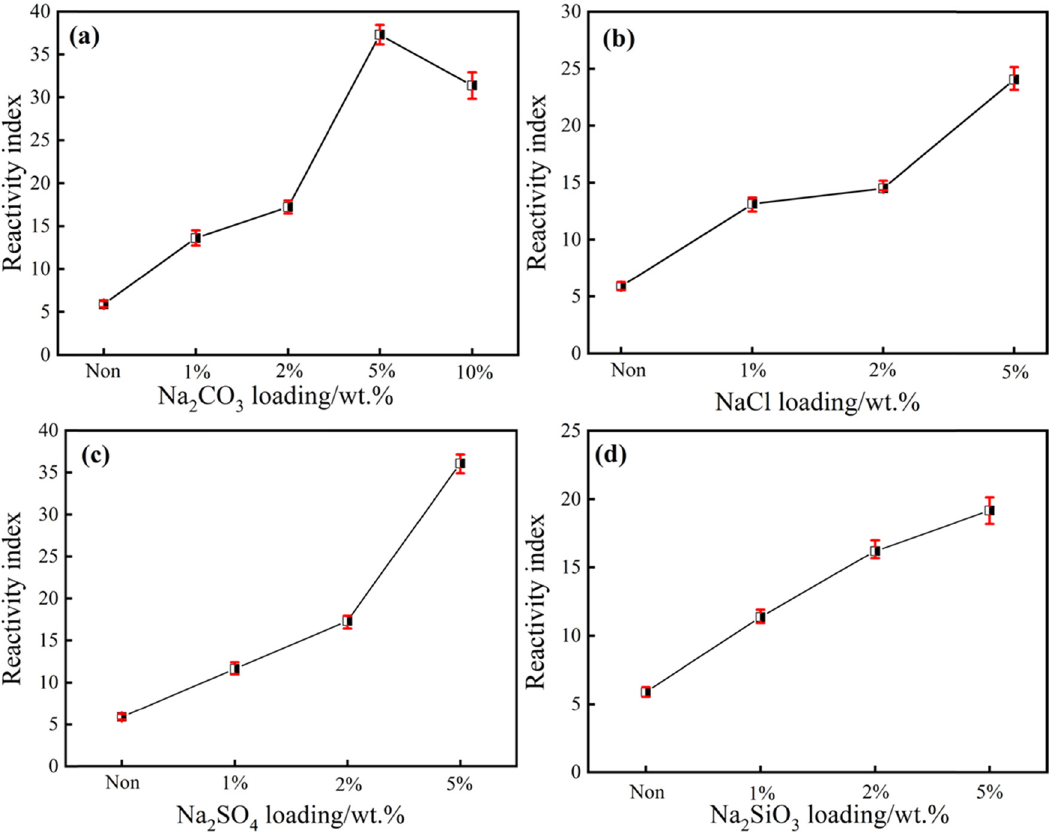
Figure 3: E ff ect of Na - based fl ux agent content on the reactivity index of ZJX char: ( a ) Na 2 CO 3 , ( b ) NaCl, ( c ) Na 2 SO 4 and ( d ) Na 2 SiO 3 .